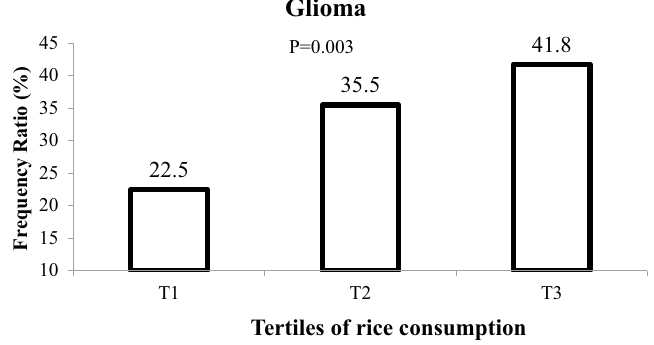
Figure 2. Frequency ratio of glioma across tertiles of rice consumption.